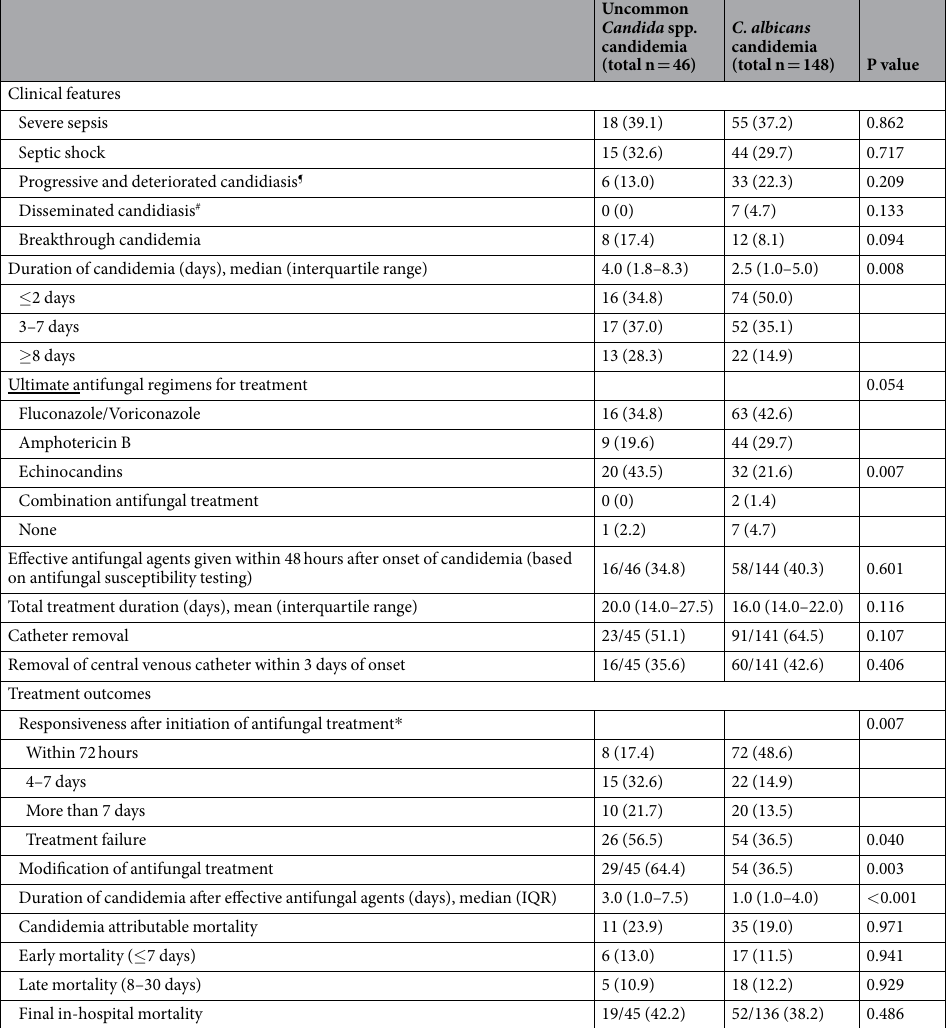
Table 3. Clinical features, treatment and outcomes of candidemia caused by uncommon Candida spp. versus C. albicans candidemia. All data were expressed as number (percentage %), unless indicated otherwise. ¶ Defined as candidemia episodes with more disseminated candidiasis and/or progressive multi-organ failure even after effective antifungal agents. # Indicated positive Candida isolates recovered from more than two sterile sites, in addition to primary bloodstream infection. * Responsiveness to antifungal agents was defined according to the consensus criteria of the Mycoses Study Group and European Organization for Research and Treatment of Cancer 33